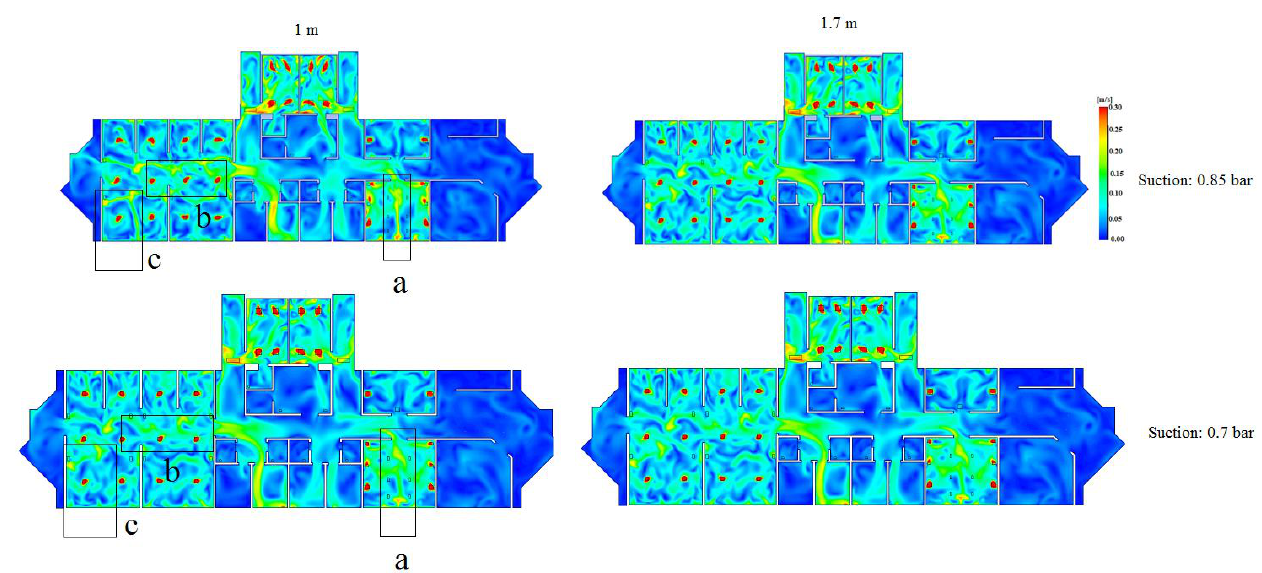
Figure 9. Velocity profiles for the 1 m and 1.7 m planes at two suction levels (0.85 and 0.7 bar).